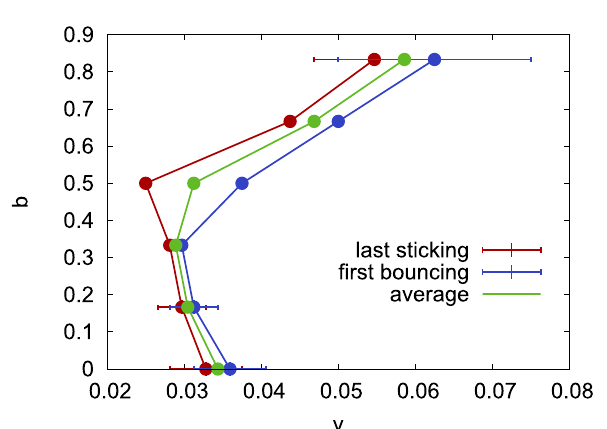
Figure 10. Dependence of largest sticking velocity and smallest bouncing velocity on impact parameters b . Their average gives an estimate of the bouncing velocity v b . Error bars for b the statistics shown in Fig. 11. This figure provides detailed information on the boundary between sticking and bouncing collisions appearing on the low-velocity side of Fig.